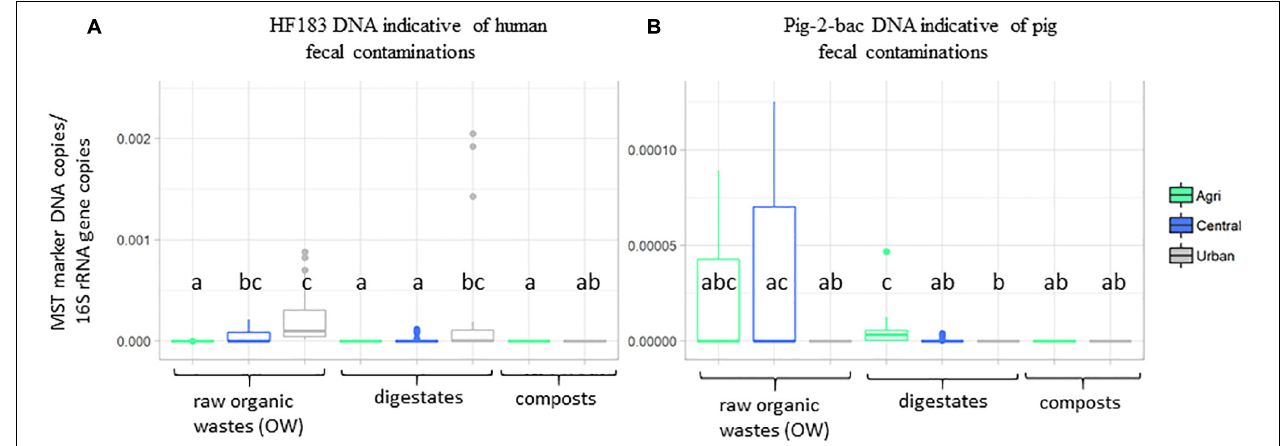
FIGURE 1 | Boxplots showing the relative occurrences of two DNA markers indicative of human and pig fecal contaminations. Datasets are from Supplementary Table 4 . Numbers of (A) HF183 and (B) pig-2-bac DNA copies per gram dry weight organic wastes, composts, or digestates normalized to 16S rRNA gene copy numbers were presented according to OW origins (agricultural, urban, and central). Boxplots show the minimum, first quartile (Q1), median, third quartile (Q3), and maximum relative abundances observed among the datasets. Outliers or unexpected values are indicated by dots. Samples used in these analyses are those of